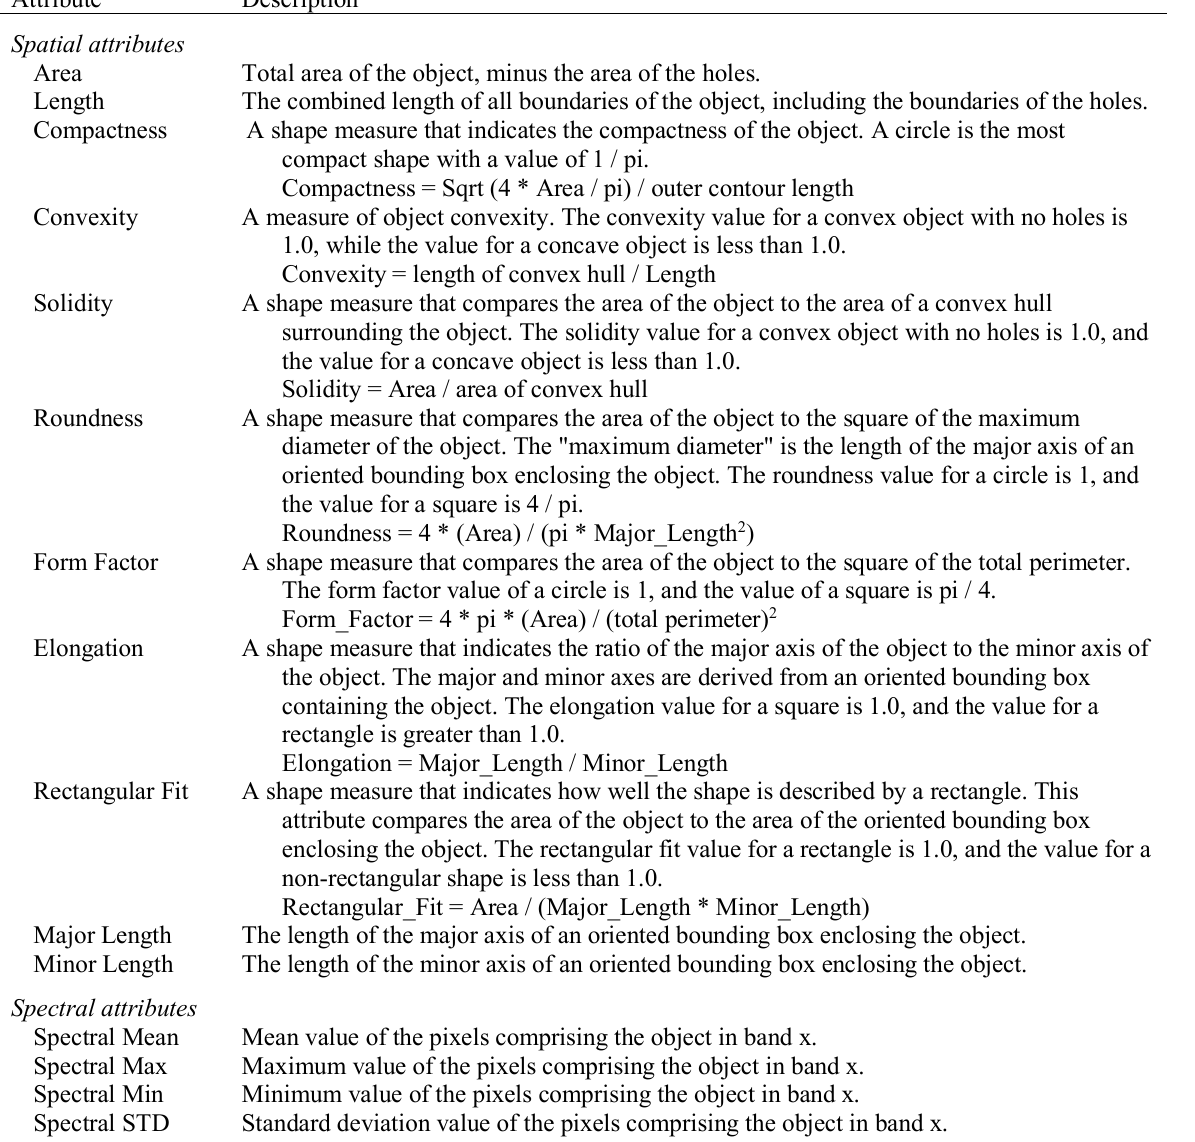
Table A1.1. List of spatial, spectral and texture attributes used to classify Snow Geese in aerial imagery of Canadian Arctic breeding colonies. Each spectral and texture attribute is calculated for each of the image’s spectral bands (in this case, red, green and blue). Attribute descriptions are from ENVI 5.3 (Exelis Visual Information Solutions, Boulder, CO, USA) help